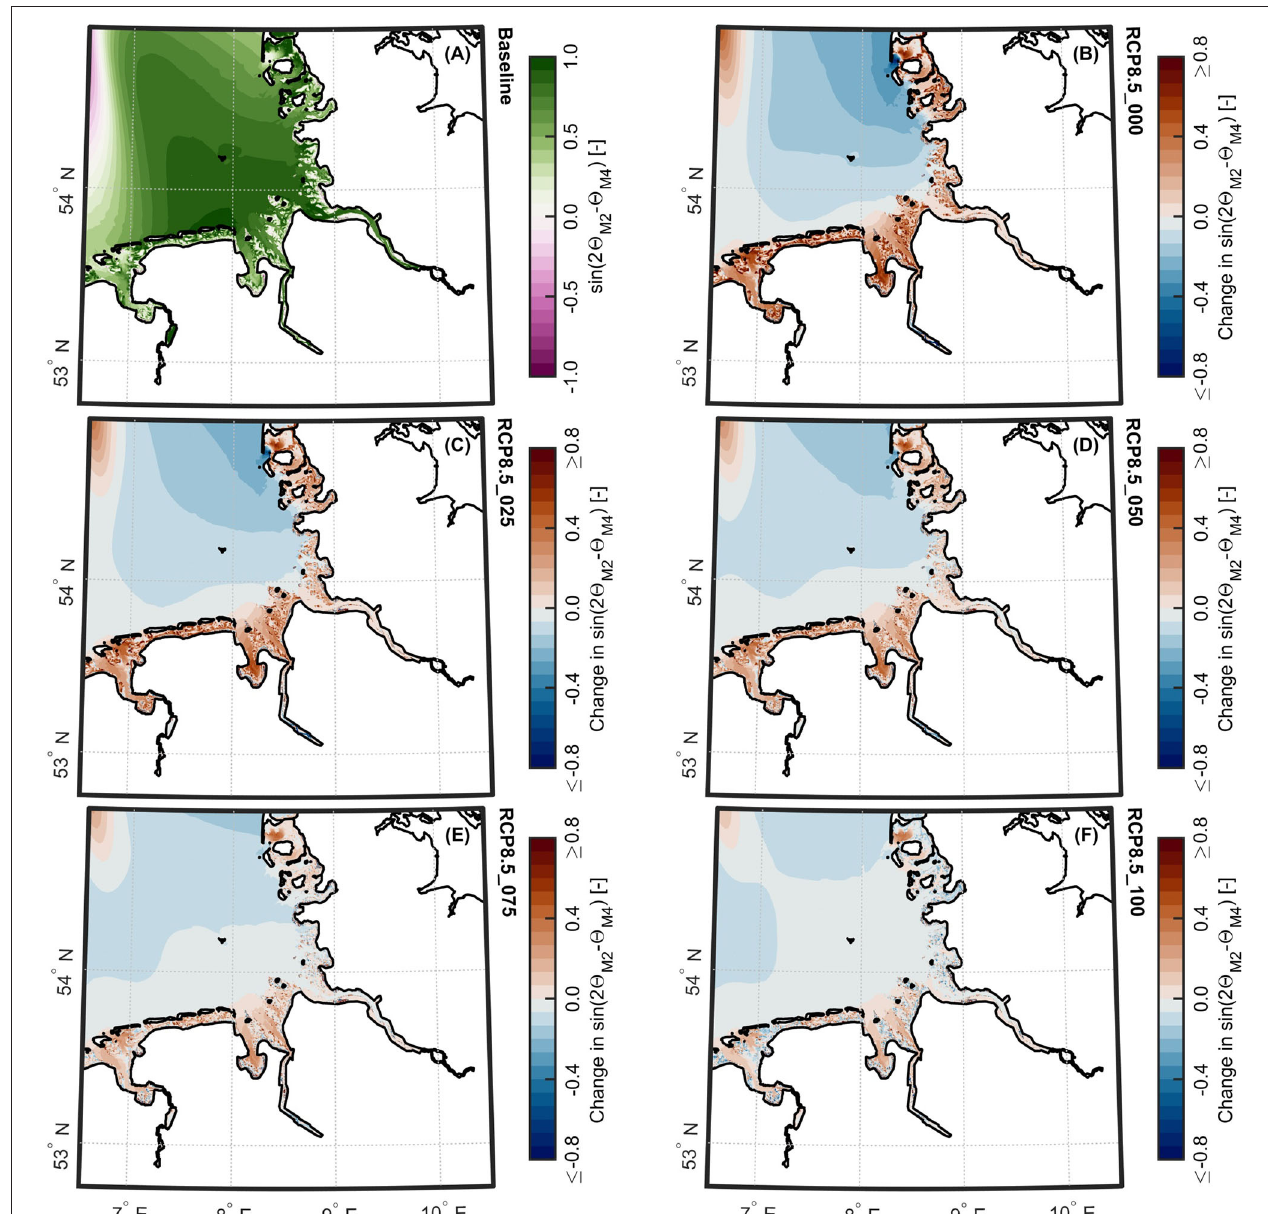
FIGURE 10 | Flood and ebb dominance for the German Bight resulting from the combinations of 0.8m SLR projection and various cumulative rates of vertical accretion. (A) Map of flood and ebb dominance for the German Bight for the baseline scenario, according to the 3-month period from September 1 to December 1, 2012. Relative changes in flood and ebb dominance for scenarios (B) RCP8.5_000, (C) RCP8.5_025, (D) RCP8.5_050, (E) RCP8.5_075, and (F) RCP8.5_100. In panel (A) , values >0 indicate flood dominance, with values <0 signaling ebb dominance. In panels (B) to (F) , values >0 indicate increases in flood dominance or decreases in ebb dominance, while values <0 signal increased ebb dominance or decreased flood